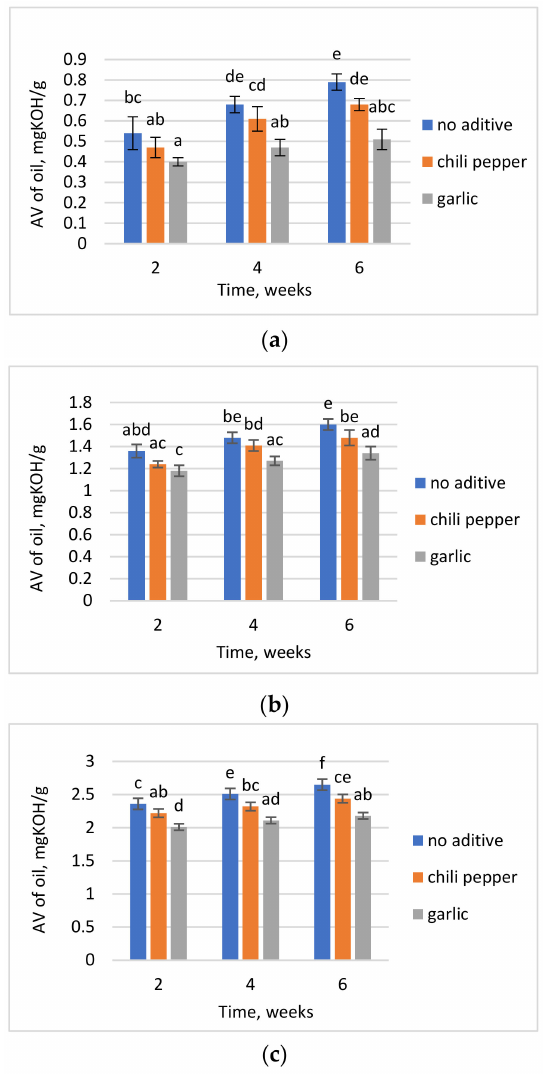
Figure 1. Effect of additives on the acid value of stored oils: ( a )—flax seed oil; ( b )—hemp seed oil; ( c )—black cumin seed oil. The values designated by the different small letters are significantly different ( α =